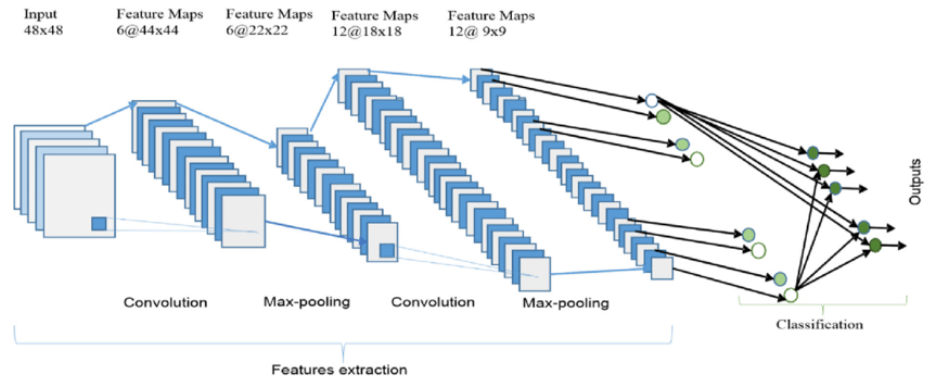
Figure 3. CNN Architecture